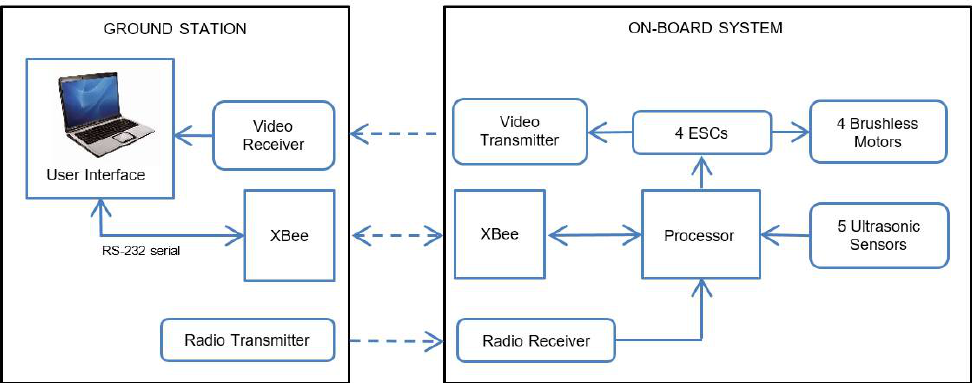
Figure 1. The UAV and ground station system.